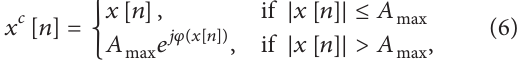
Figure 5: PSD of the FBMC signal as a function of the number of subcarriers ( N